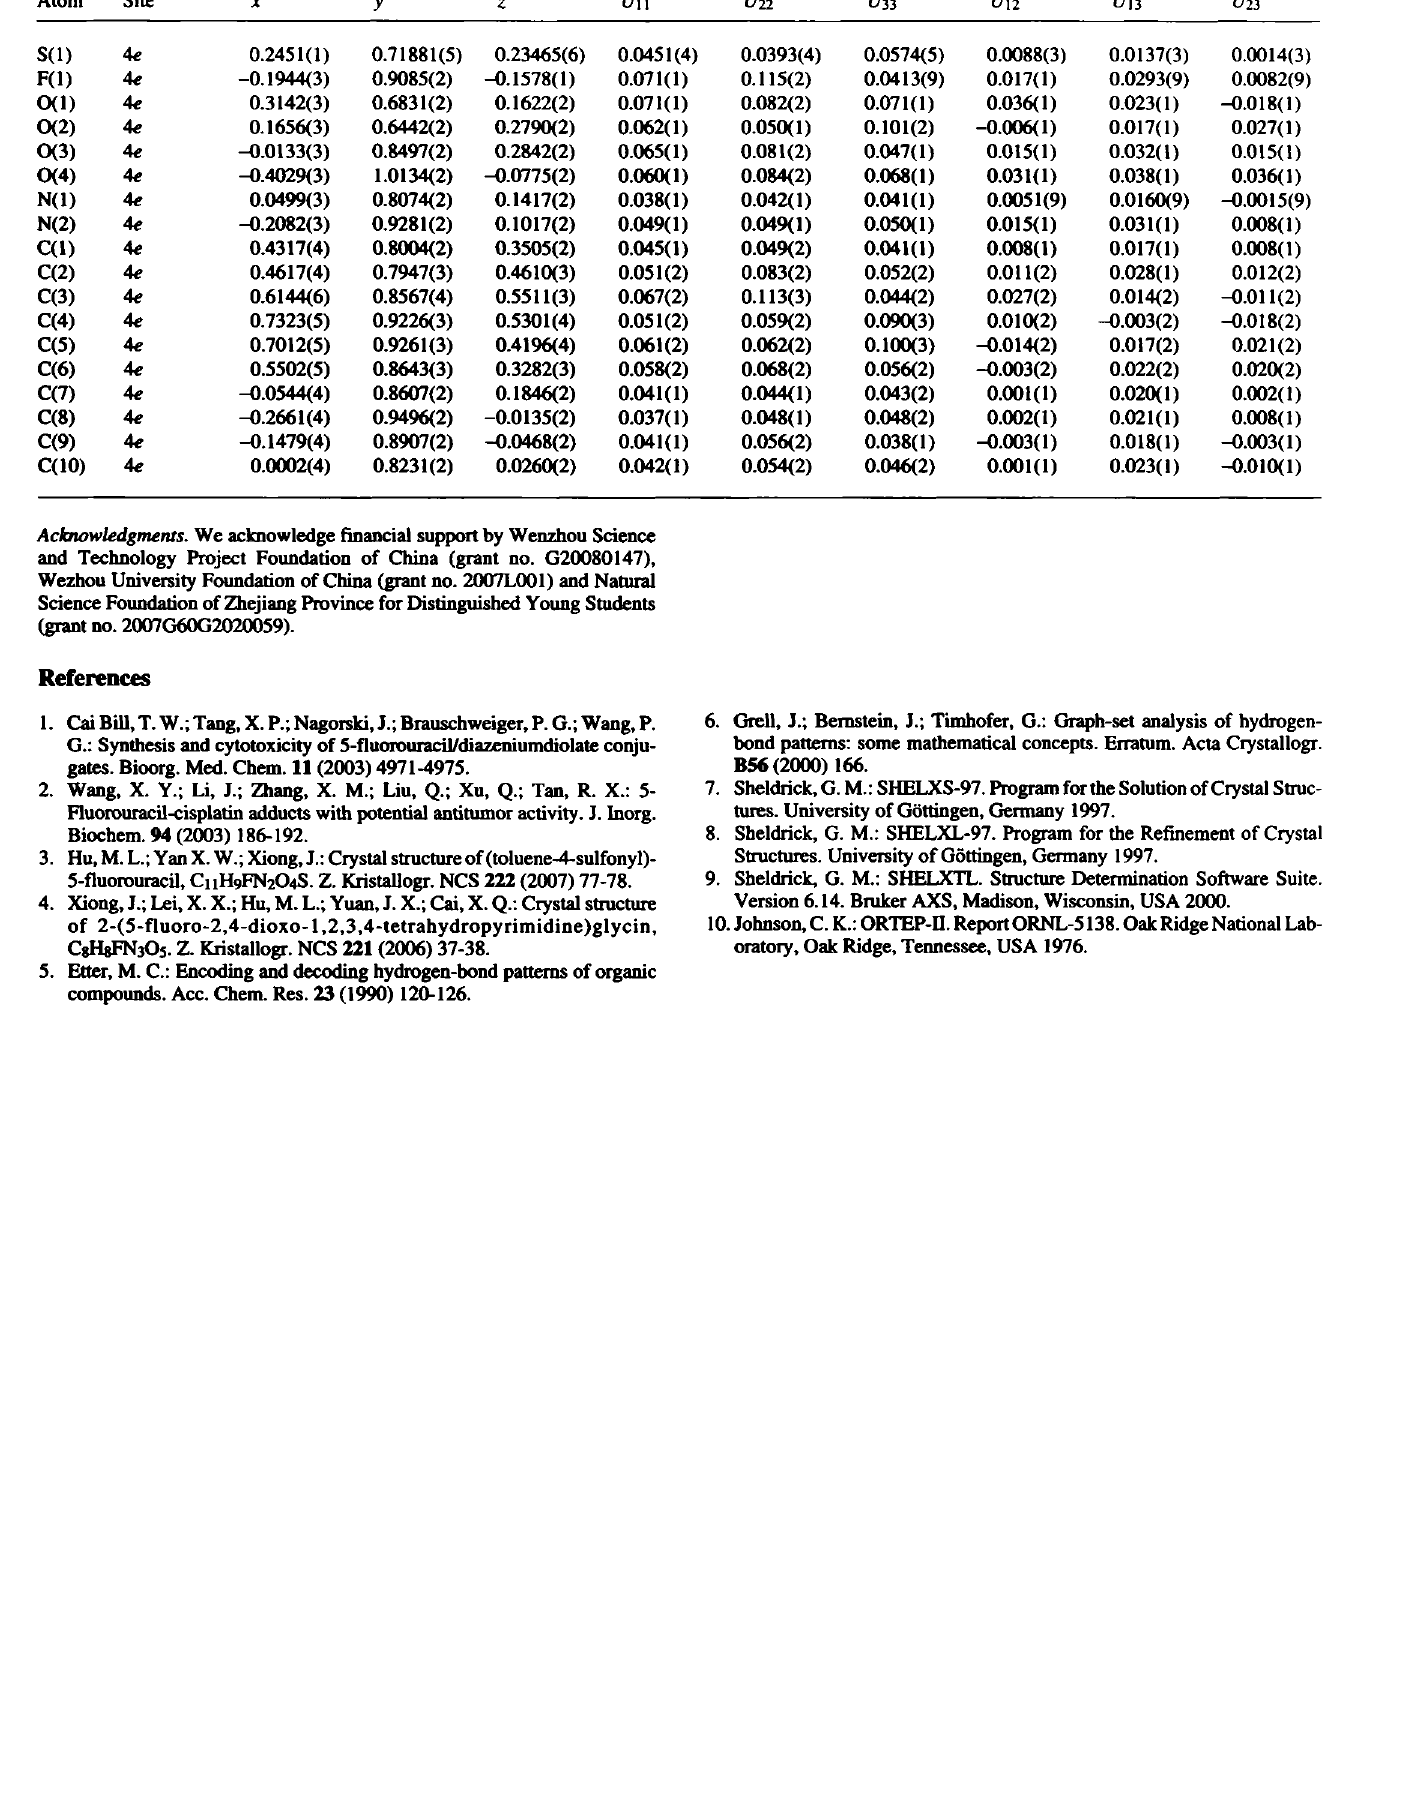
Table 3. Atomic coordinates and displacement parameters (in Â 2